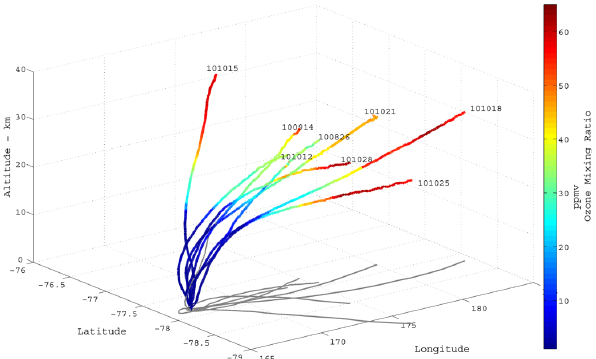
Fig. 3. Ozone profiles measured by zero-pressure balloons at Mc- Murdo during the 2010 Concordiasi campaign. The figure presents the flight paths of the 8 balloons equipped with GPS receivers. Grey lines display the shadows of the trajectories. Each profile is named by its date (“yymmdd”) at the top of the profile, and ozone units are given in ppmv. The black square in Fig. 1 identifies the entire latitude/longitude region covered by the